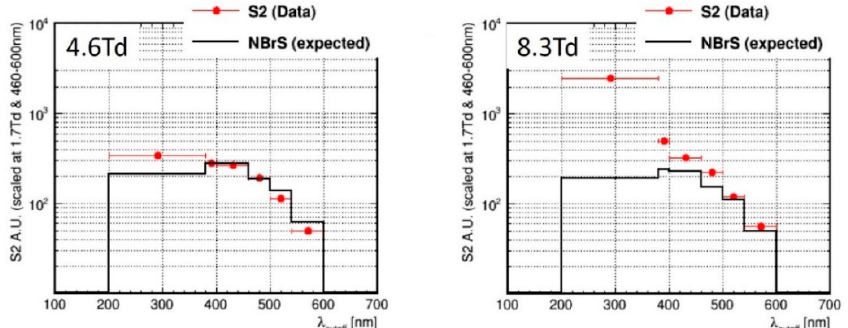
Figure 10. Photon emission spectra of proportional EL in Ar in the UV and visible range [19], measured at room temperature in [19] (data points) in comparison with those of the NBrS EL theory [9] (lines), at reduced electric field of 4.6 and 8.3 Td.